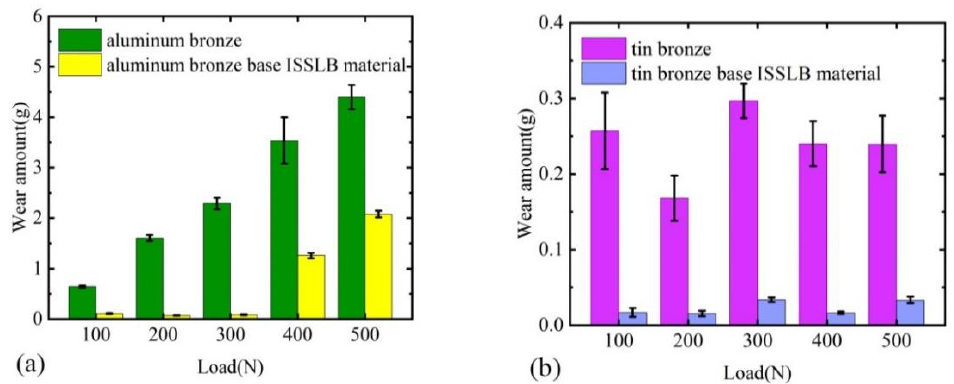
Figure 4. Comparison of wear amount: ( a ) aluminum bronze and aluminum bronze-based ISSLB materials; ( b ) tin bronze and tin bronze-based ISSLB materials.